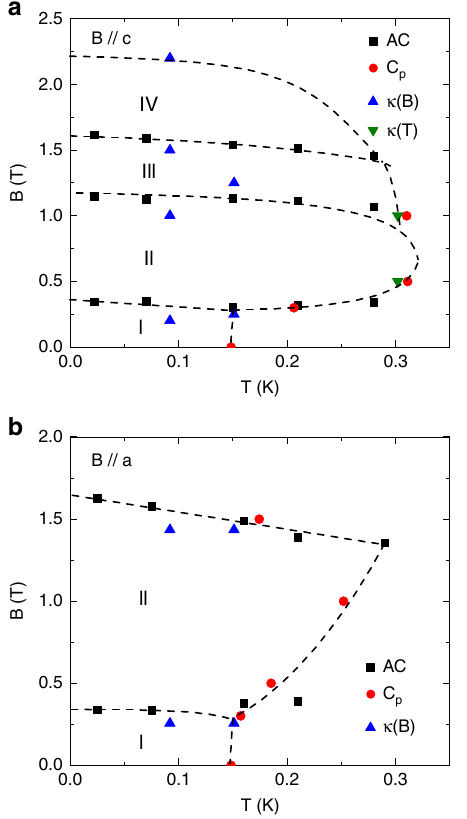
Fig. 6 Phase diagram of Na 2 BaCo(PO 4 ) 2 . The magnetic phase diagrams of Na 2 BaCo(PO 4 ) 2 for B // c ( a ) and B // a ( b ). The data points are obtained from the AC susceptibility (AC), speci fi c heat ( C p ) and temperature or fi eld dependence of thermal conductivity ( κ ( T ) and κ ( B )) measurements. The dashed lines are phase boundaries. For B // c , there are four phases (I, II, III, and IV) in the low-temperature and low- fi eld region. Whereas, there are two phase (I and II) at low-temperature and low- fi eld for B // a . The dashed lines are a guide to the plateau. This makes Na 2 BaCo(PO 4 ) 2 a unique TAF with easy axis anisotropy to exhibit a UUD phase.